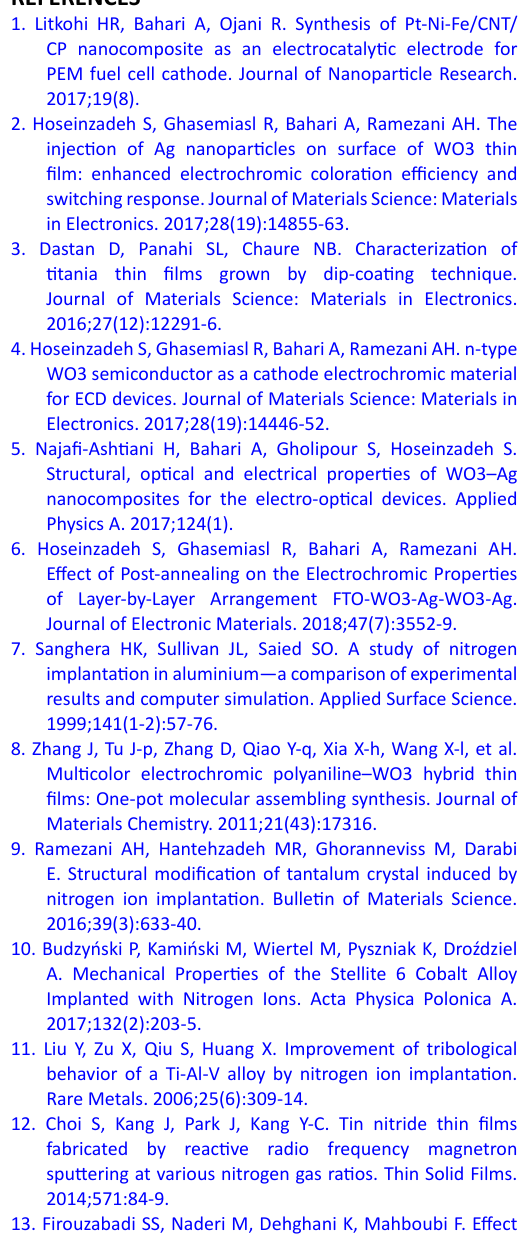
285 J Nanostruct 9(2): 276-286,